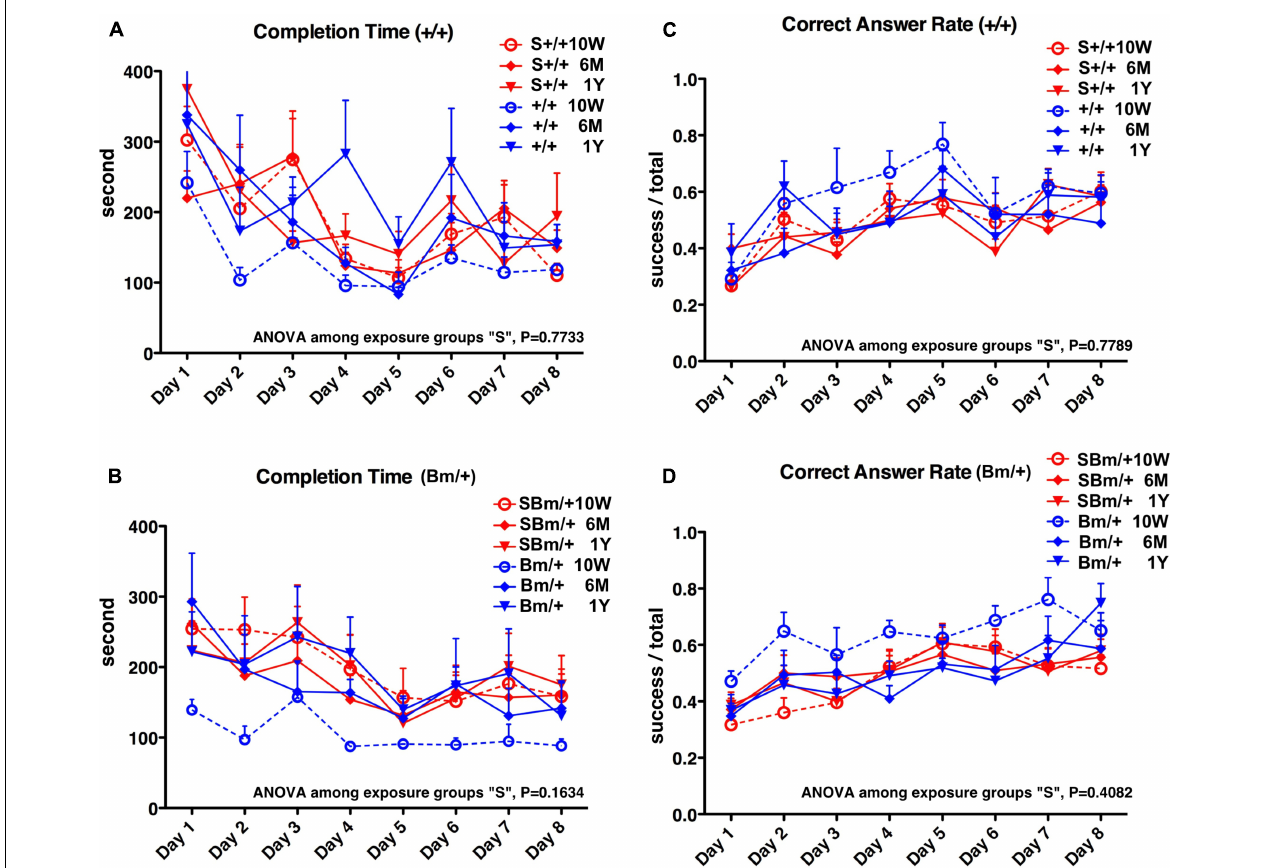
FIGURE 5 | Exposure to inhalational anesthetics impaired spatial working memory in young mice. Eight-arm radial maze testing was performed in wild-type mice (A,C) and mutant-BiP mice (B,D) at 10 weeks, 6 months, and 1 year after birth. Tests were performed over 8 days at each time point. Completion times are shown as the average time (seconds) of each group + SEM. Differences among exposure groups were determined by one-way repeated measures ANOVA. (A) Wild-type mice with fetal anesthetic exposure (S+/+, n = 12; red lines) and without exposure (+/+, n = 6, blue lines same as Figure 1 ). ANOVA among exposure groups, P = 0.7733. (B) Mutant-BiP mice with fetal anesthetic exposure (SBm/+, n = 16; red lines) and without exposure (Bm/+, n = 8, blue lines same as Figure 1 ). ANOVA among exposure groups, P = 0.1634. Completion times are the average time (seconds) of each group + SEM. Differences among exposure groups were determined by one-way repeated measures ANOVA. (C) Wild-type mice with fetal anesthetic exposure (S+/+; red lines) and without exposure (+/+; blue lines same as Figure 1 ). ANOVA among exposure groups, P = 0.7789. (D) Mutant-BiP mice with fetal anesthetic exposure (SBm/+; red lines) and without exposure (Bm/+, blue lines same as Figure 1 ). ANOVA among exposure groups, P = 0.4082. The ratio of successful attempts to overall attempts was the correct answer rate